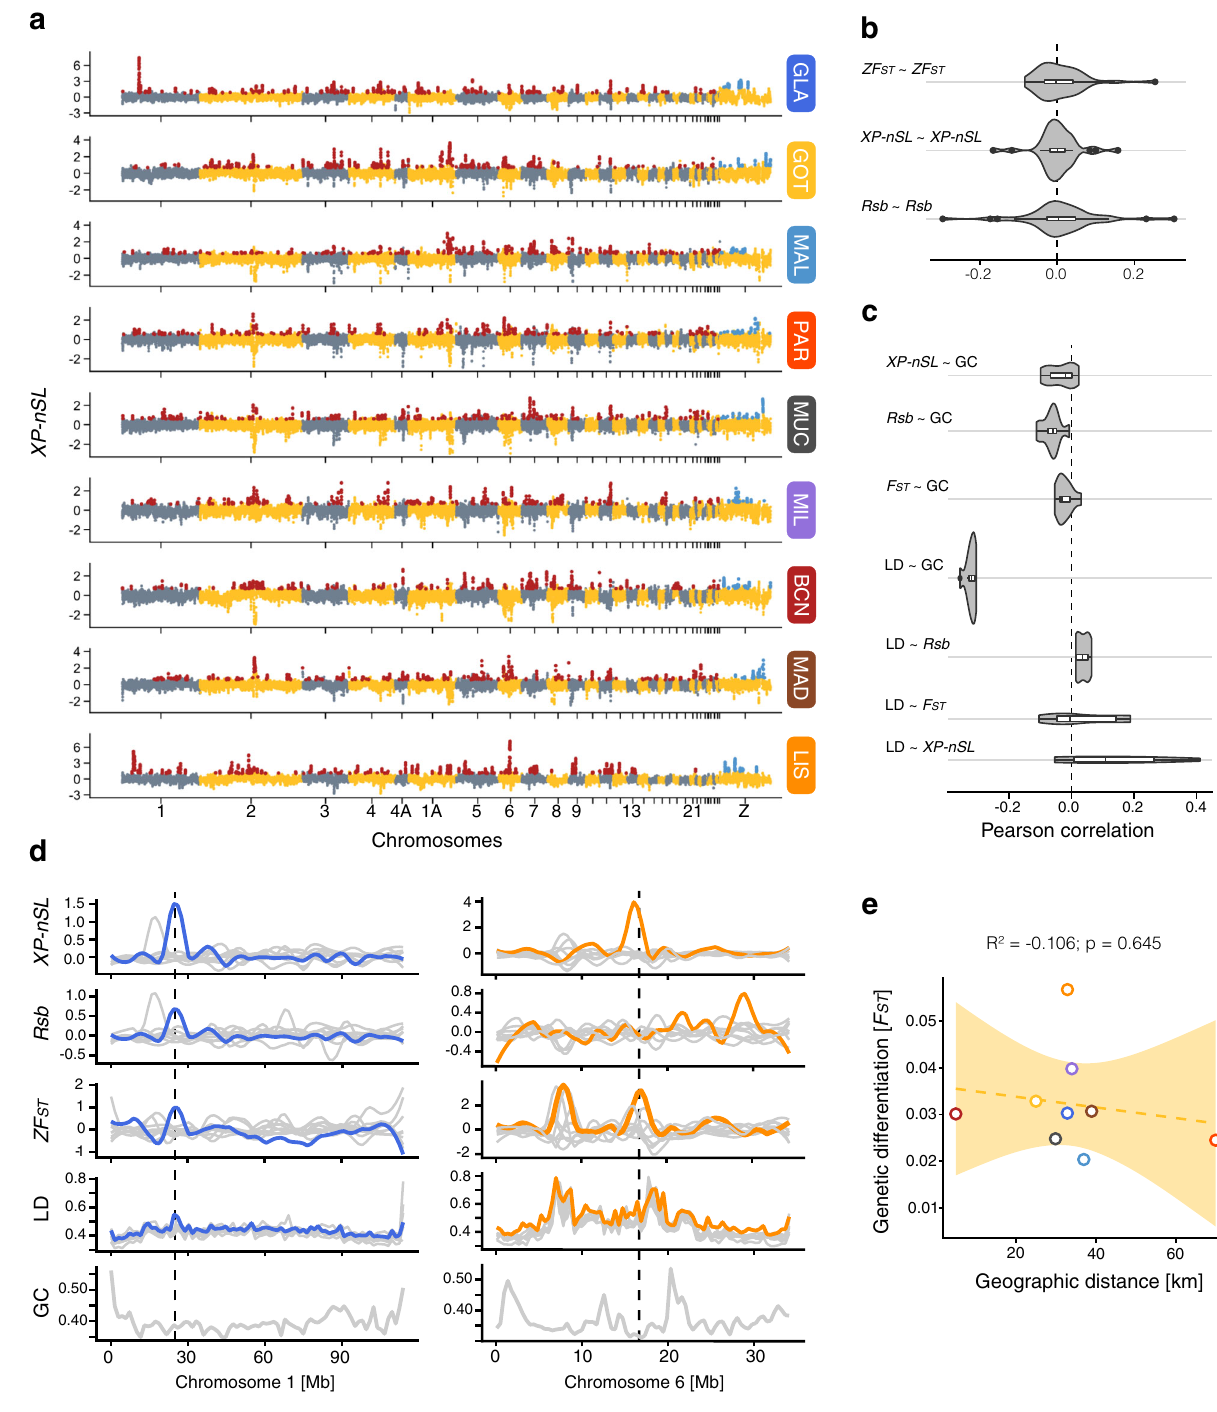
200 kb non-sliding windows). LD is correlated with population- speci fi c recombination rates and the strength of selection, while intronic GC-content is a surrogate for the long-term recombina- tion rate variation across the great tit genome, i.e., a higher GC- content will indicate a higher recombination rate 51,52 . To con fi rm that both proxies provide similar pictures of the recombination landscape, we tested their correlation across all population pairs. Indeed, LD and GC-content, were (negatively) correlated in all populations (Fig. 4c), suggesting that the general effect of recom- bination on the genomic diversity landscape is broadly